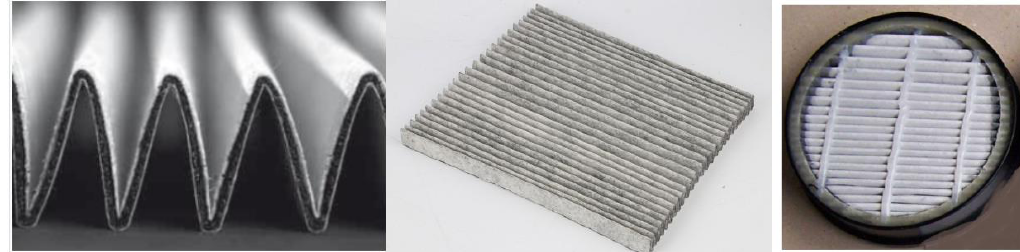
Figure 12. Example of folded filters that were made from a nonwoven bicotextile, PA-6 nanofibers filtration membrane, and adsorption textile (AT) sorption layer. The left is a cut of the folds, the middle is a view of the crimp material, and the right is tested filter.